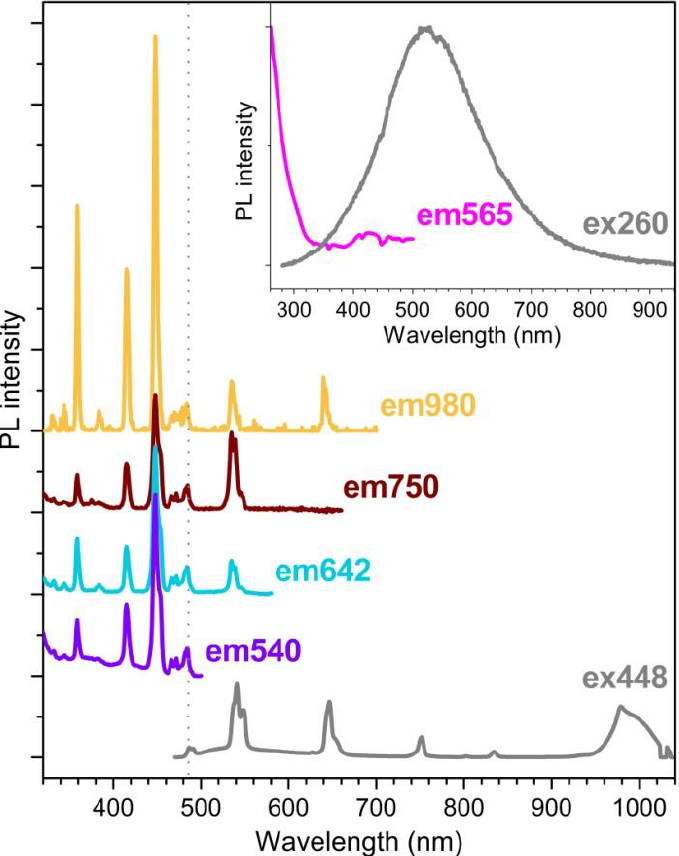
Figure 7. PLE spectra of emission signals at 540, 642, 750 and 980 nm and PL spectrum (grey line) under 448 excitation of Ce_0 sample; each PLE spectrum is normalized to the signal at 483 nm, corresponding to the Ho 3+ 5 I 8 → 5 F 3 transition, which is marked by the vertical dotted line. In the inset, PLE spectrum of emission signal at 565 nm and PL spectrum under 260 nm excitation of Ce_0 sample.